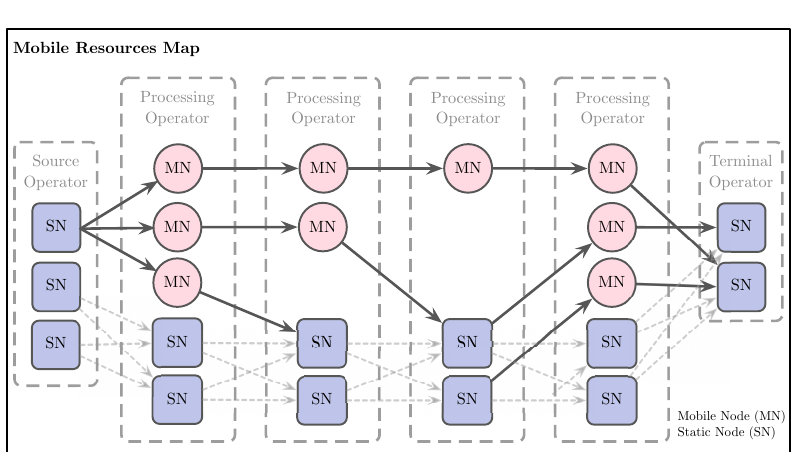
Figure 3. Example of mapping mobile